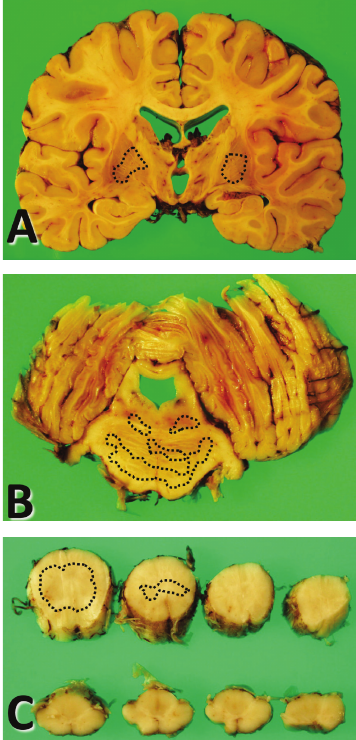
Figure 1: (A–C) Macroscopic findings. Severe atrophy of the paleostriatum together with dilatation of the lateral ventricle is evident in the coronal sections, while the thickness of the cerebral cortex is relatively intact (A). The brainstem, the gray matter of the cerebellar hemisphere (B), and the spinal cord (C) also show marked